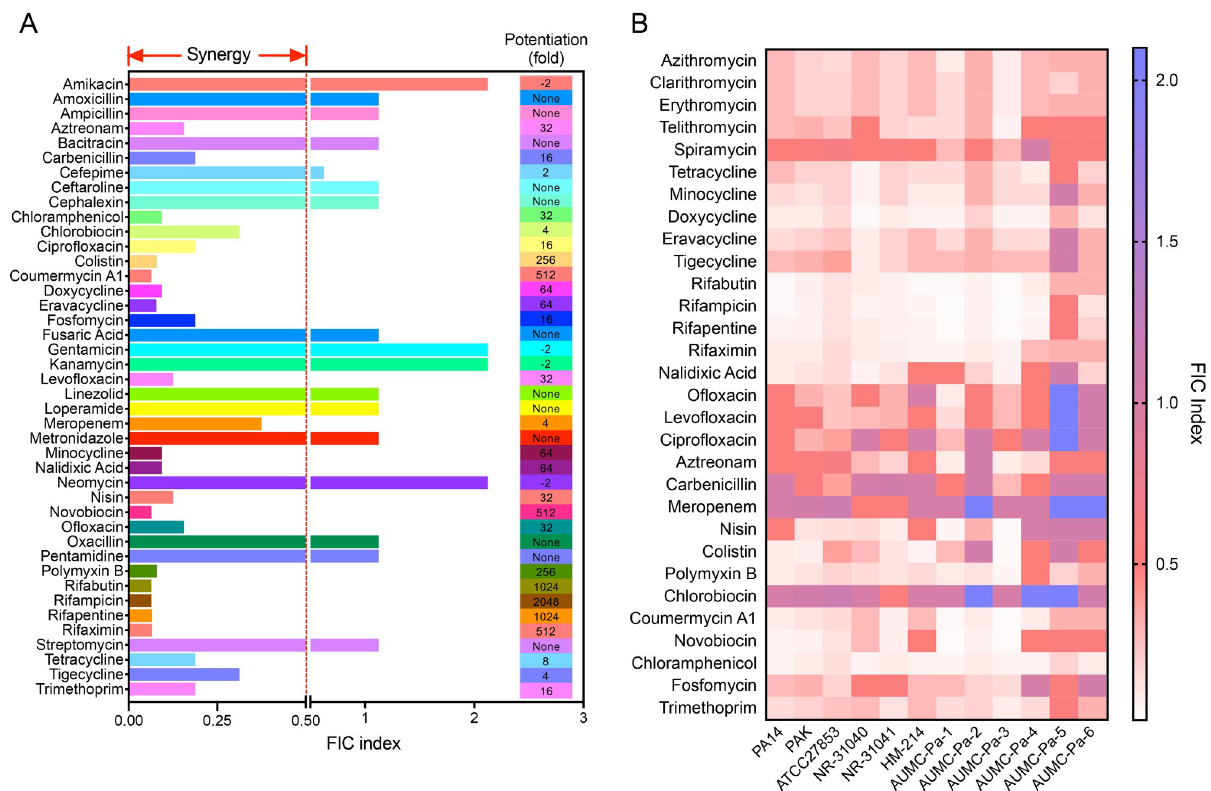
Fig 6. D-11 enhances the activity of multiple antibiotics. ( A ) synergistic effects of D-11 with multiple antibiotics. The FICI values of D-11 combined with multiple antibiotics and the fold change of MICs of those antibiotics in the presence of 4 μ M D-11. ( B ) The heat map of the FIC indices for the synergistic effects of multiple antimicrobial agents combined with 4 μ M D-11 against three standard P . aeruginosa strain and nine clinical isolates. Synergy is indicated by an FIC index � 0.5.